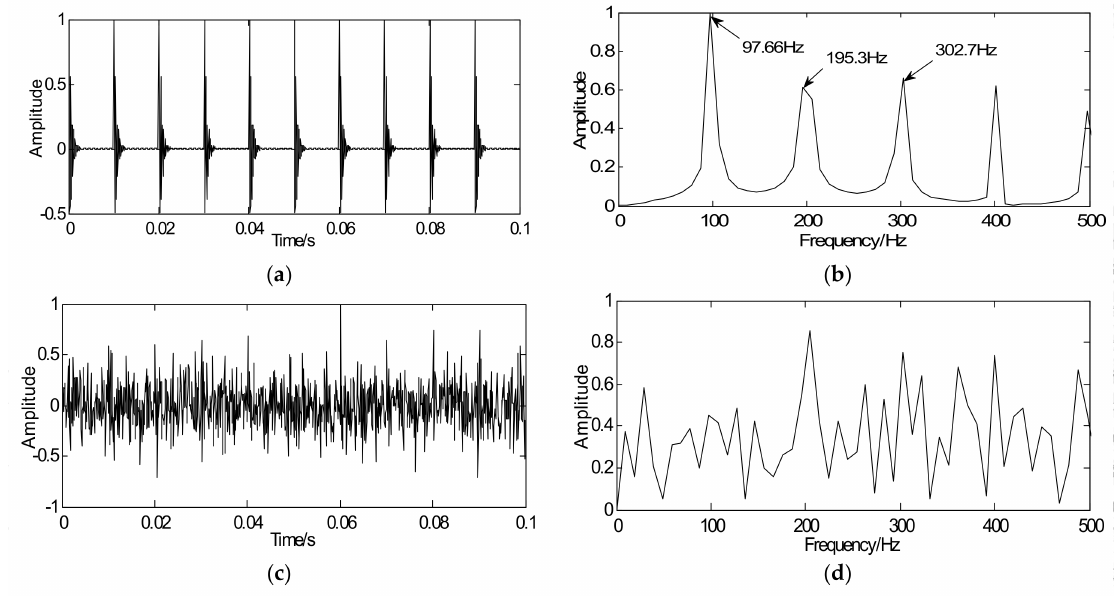
Figure 4. Simulated signals: ( a ) time-domain waveform of simulated signal, ( b ) envelope spectrum of simulated signal, ( c ) simulated signal with noise, and ( d ) envelope spectrum of signal with